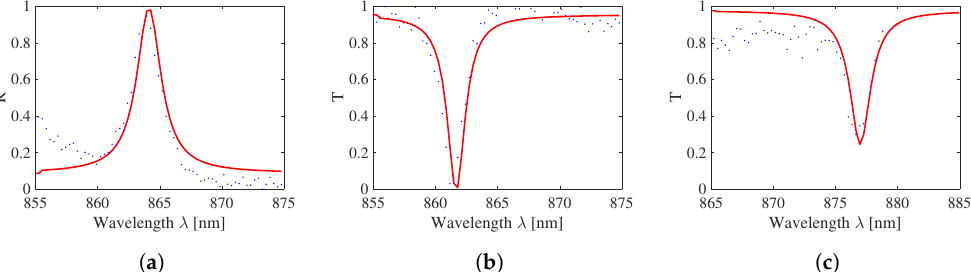
Figure 19. A measured reflection and two transmission spectra (blue dots) with their Lorentzian fitting (red line). ( a ) A reflection spectrum of a GMR grating in EpoCore. ( b ) A transmission spectrum of a GMR grating in EpoCore. ( c ) A transmission spectrum of a GMR grating in